Question: Sum up the contents of this chart in one sentence.
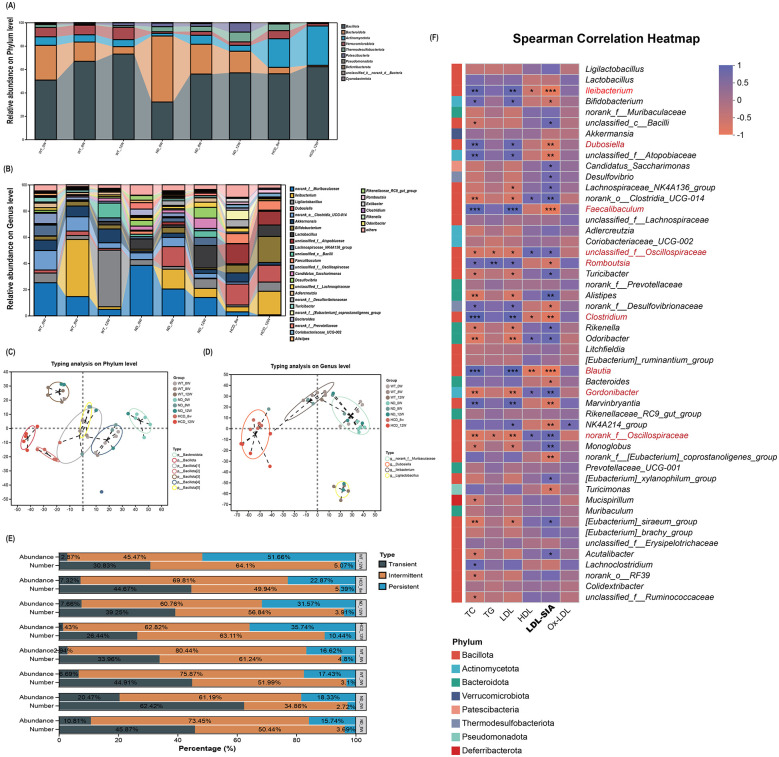
Answer: Gut Microbiome during 0–12 weeks intervention. (A–D) Species composition and diversity: (A) Relative abundance in phylum level; (B) Relative abundance in genus level; (C) Typing analysis on Phylum level of group samples relationships; (D) Typing analysis on Genus level of group samples relationships; (E) The composition of transient, intermittent, and persistent populations in the intestinal tract of each group at different time points; (F) Pearson Correlation Heatmap serum TC, TG, LDL, Ox-LDL, LDL-SIA and HDL with intestinal flora in Genus level. * denotes statistically significant differences between groups, * 0.01 < P ≤ 0.05, ** 0.001 < P ≤ 0.01, *** P ≤ 0.001.